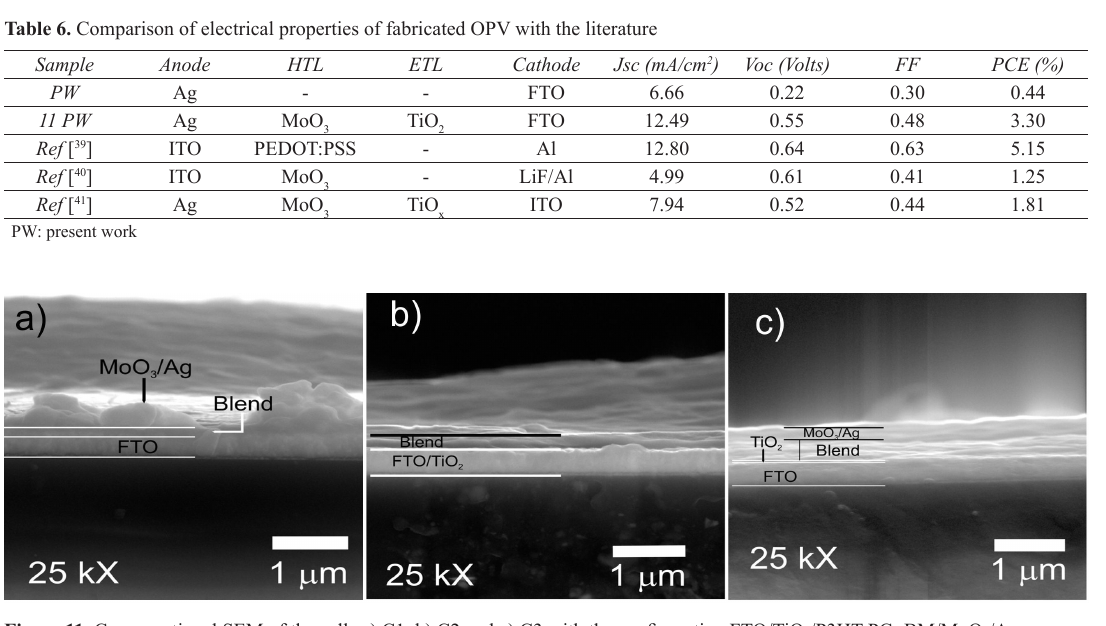
Figure 11. Cross-sectional SEM of the cells a) C1, b) C2 and c) C3 with the configuration FTO/TiO